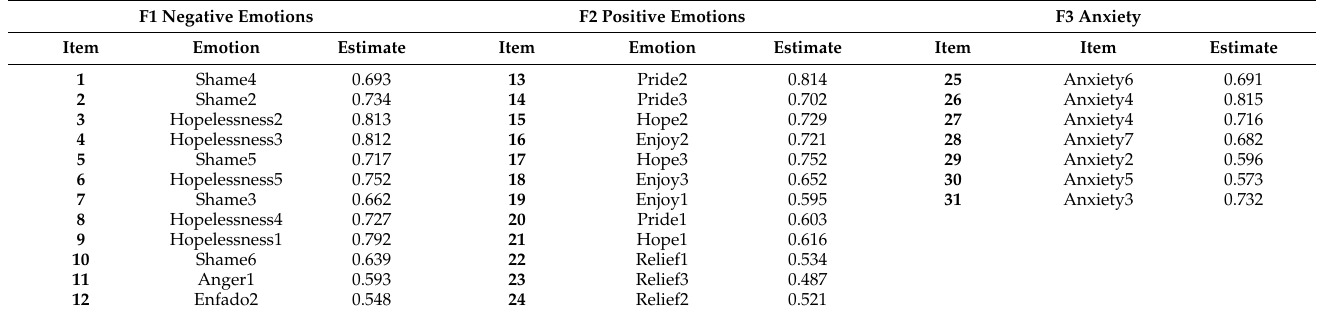
Table 3. Factorial loads of three Related Factors Model of the Exams-related Emotions Scale (EES). F1 Negative Emotions F2 Positive Emotions